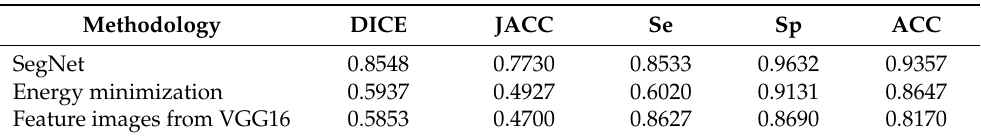
Table 1. Segmentation results of the tested methods over the Test set (600 images). Numbers represent the average values of the different segmentation performance parameters calculated over the 600 test images.